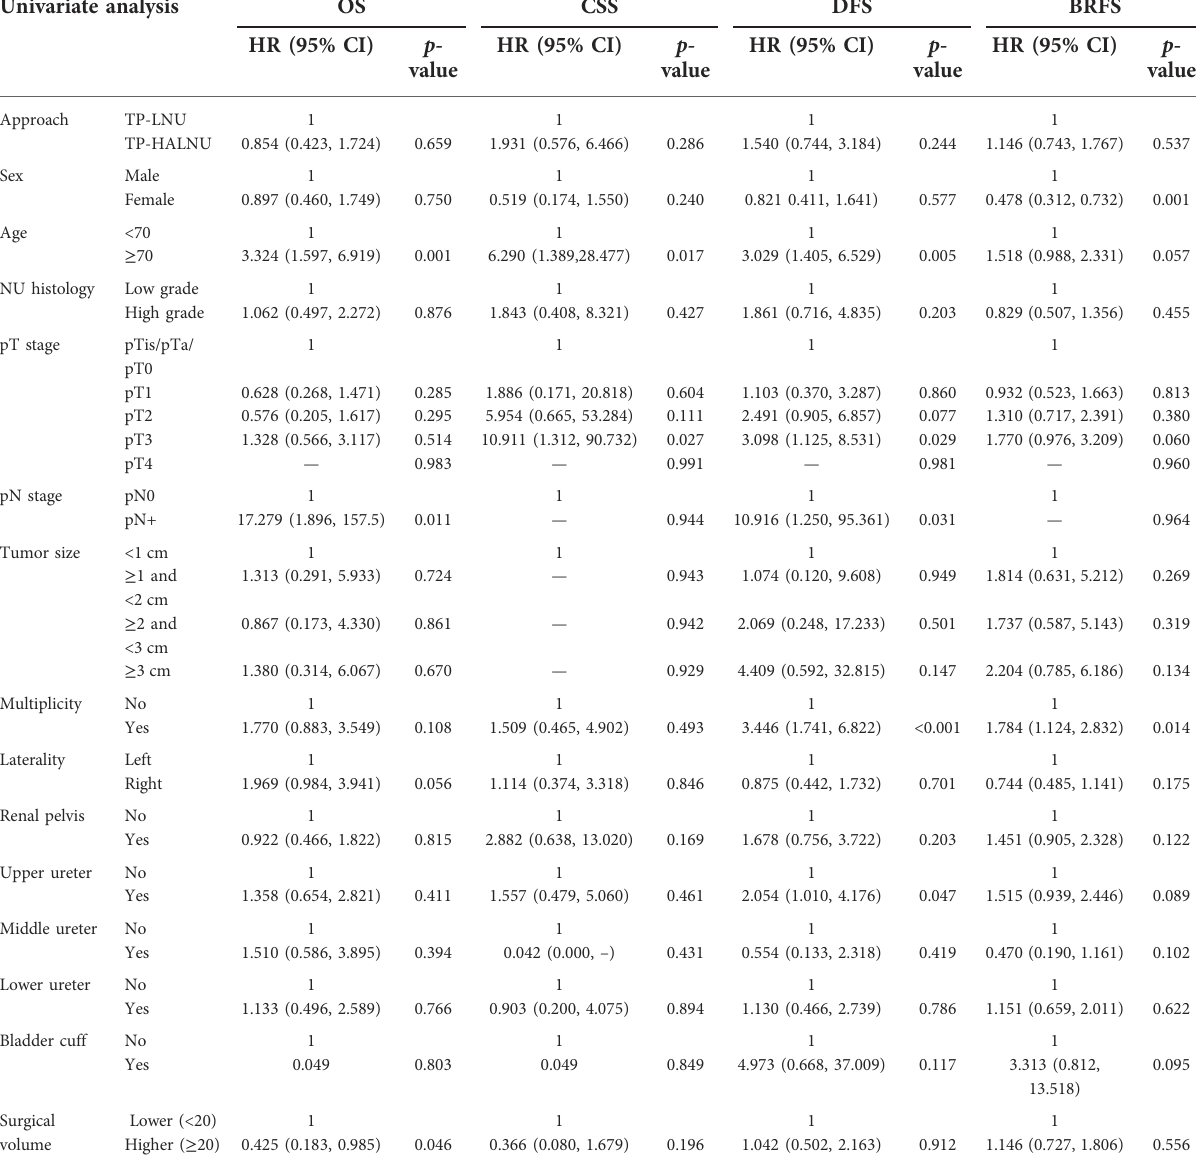
TABLE 3 Comparative univariate survival analysis of UTUC patients. Univariate